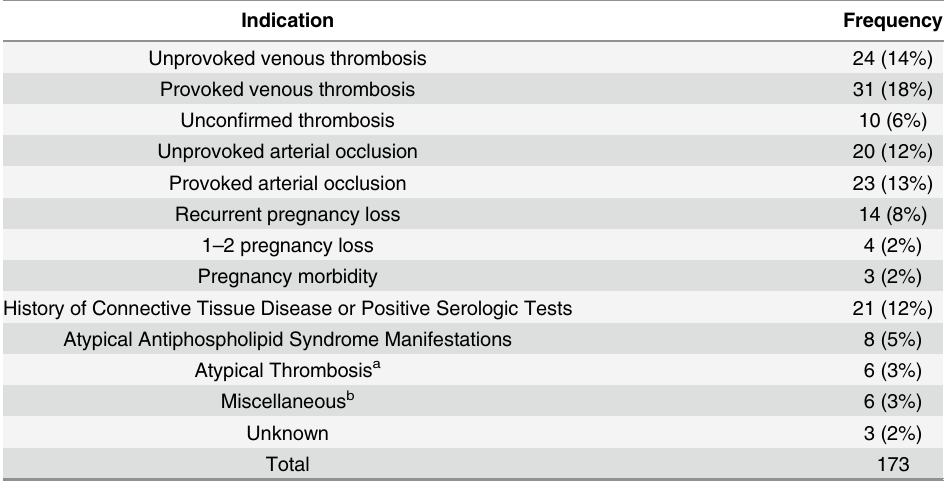
Table 1. Indications for Thrombophilia